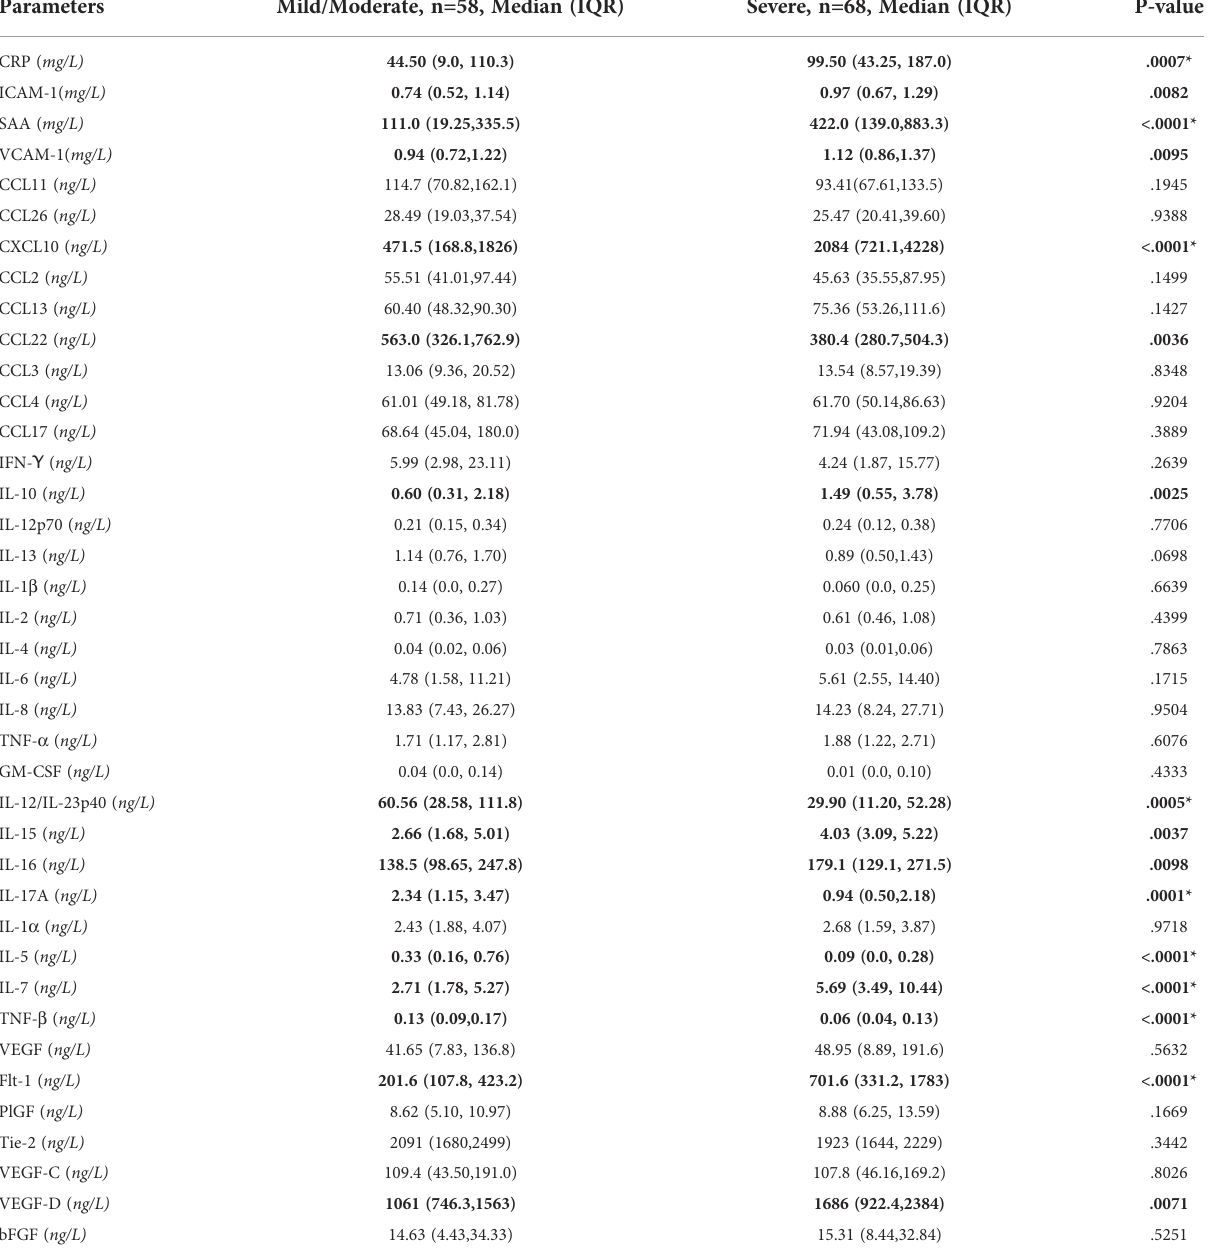
TABLE 4 Concentration of in fl ammatory biomarkers in mild/moderate versus severe COVID-19 patients. Parameters Mild/Moderate, n=58, Median (IQR) Severe, n=68, Median (IQR) P-value 44.50 (9.0, 110.3)